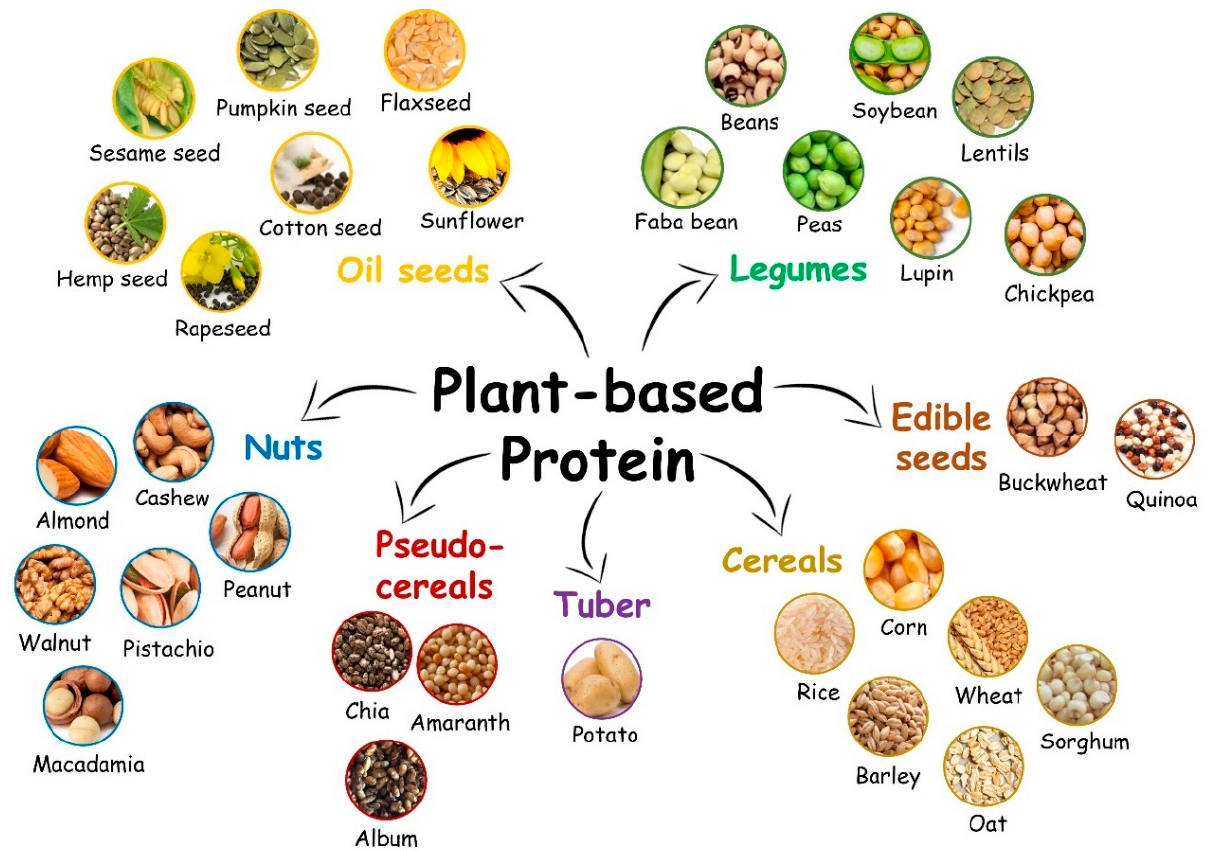
Figure 1. Major sources of plant-based proteins.